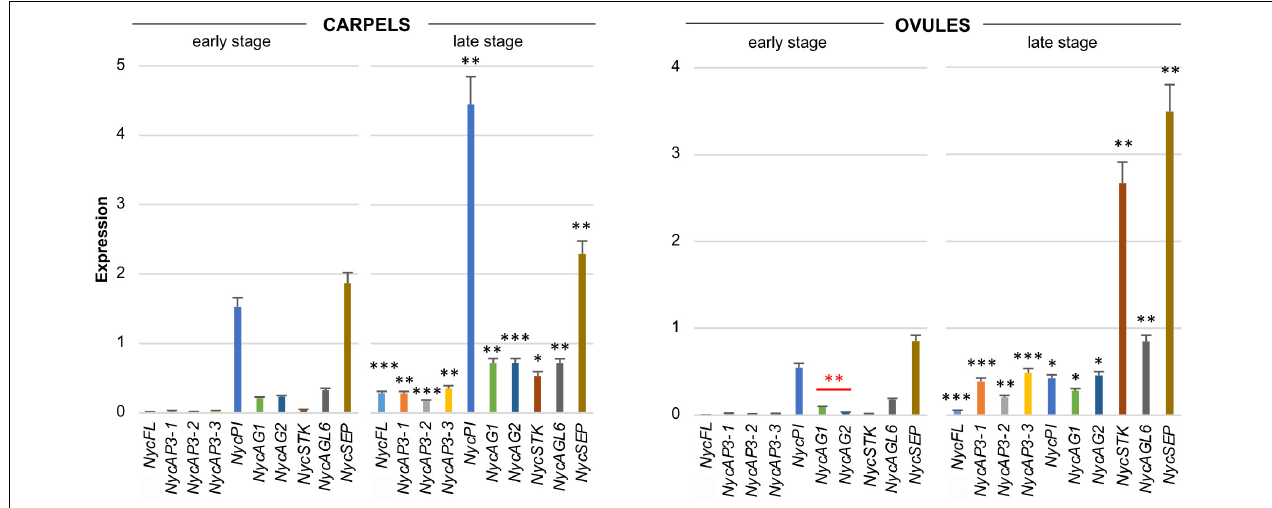
FIGURE 4 | Analysis of MADS-box gene expression during carpels and ovules development. Expression profiles of MADS-box genes obtained from carpels and ovules at two different stages of development (early and late stages) of the floral bud. The expression profiles were obtained by qPCR experiments; values in the graphs represent initial RNA quantities ± SEM. Black asterisks above an expression level indicate a significant difference between the two developmental stages, for that specific gene. Red asterisks indicate a significant difference of the expression levels of genes under the red bar ( ∗ p < 0.05; ∗∗ p < 0.01; ∗∗∗ p <